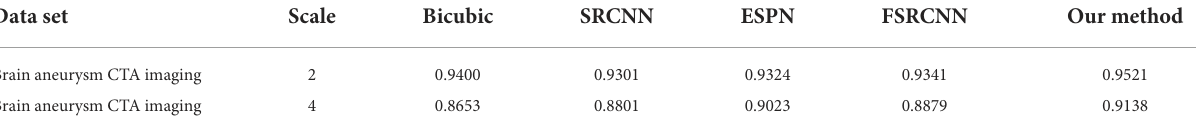
TABLE 3 SSIM experimental data.